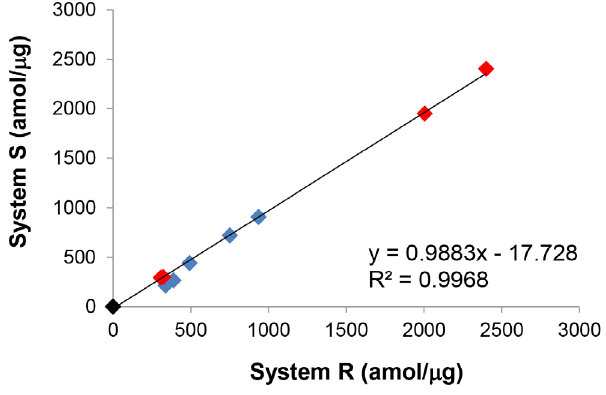
Figure 3. Precision assessment for measuring the absolute abundance of Met in 9 NSCLC and 11 GEC FFPE tissues. Each sample was analyzed on two different liquid chromatography-mass spectrometry systems operated by two different scientists. Red square: Met positive GEC tumors (4/11). Blue square: Met positive NSCLC tumors (5/9).